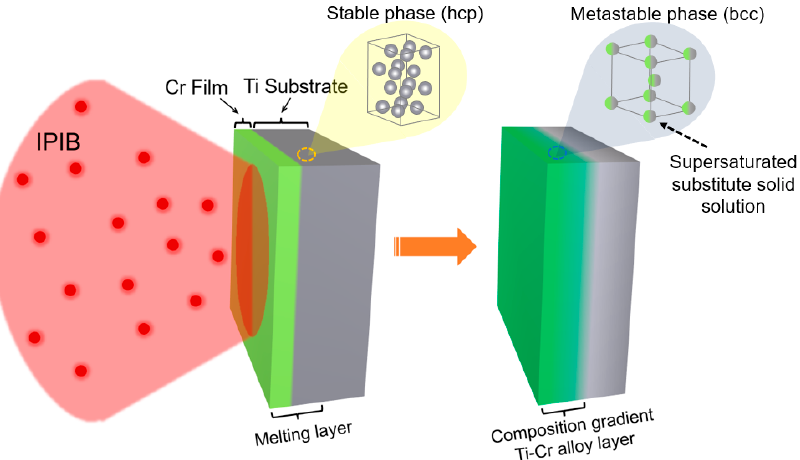
Figure 1. Scheme of the preparation process of Ti-Cr alloy coating through IPIBMM.